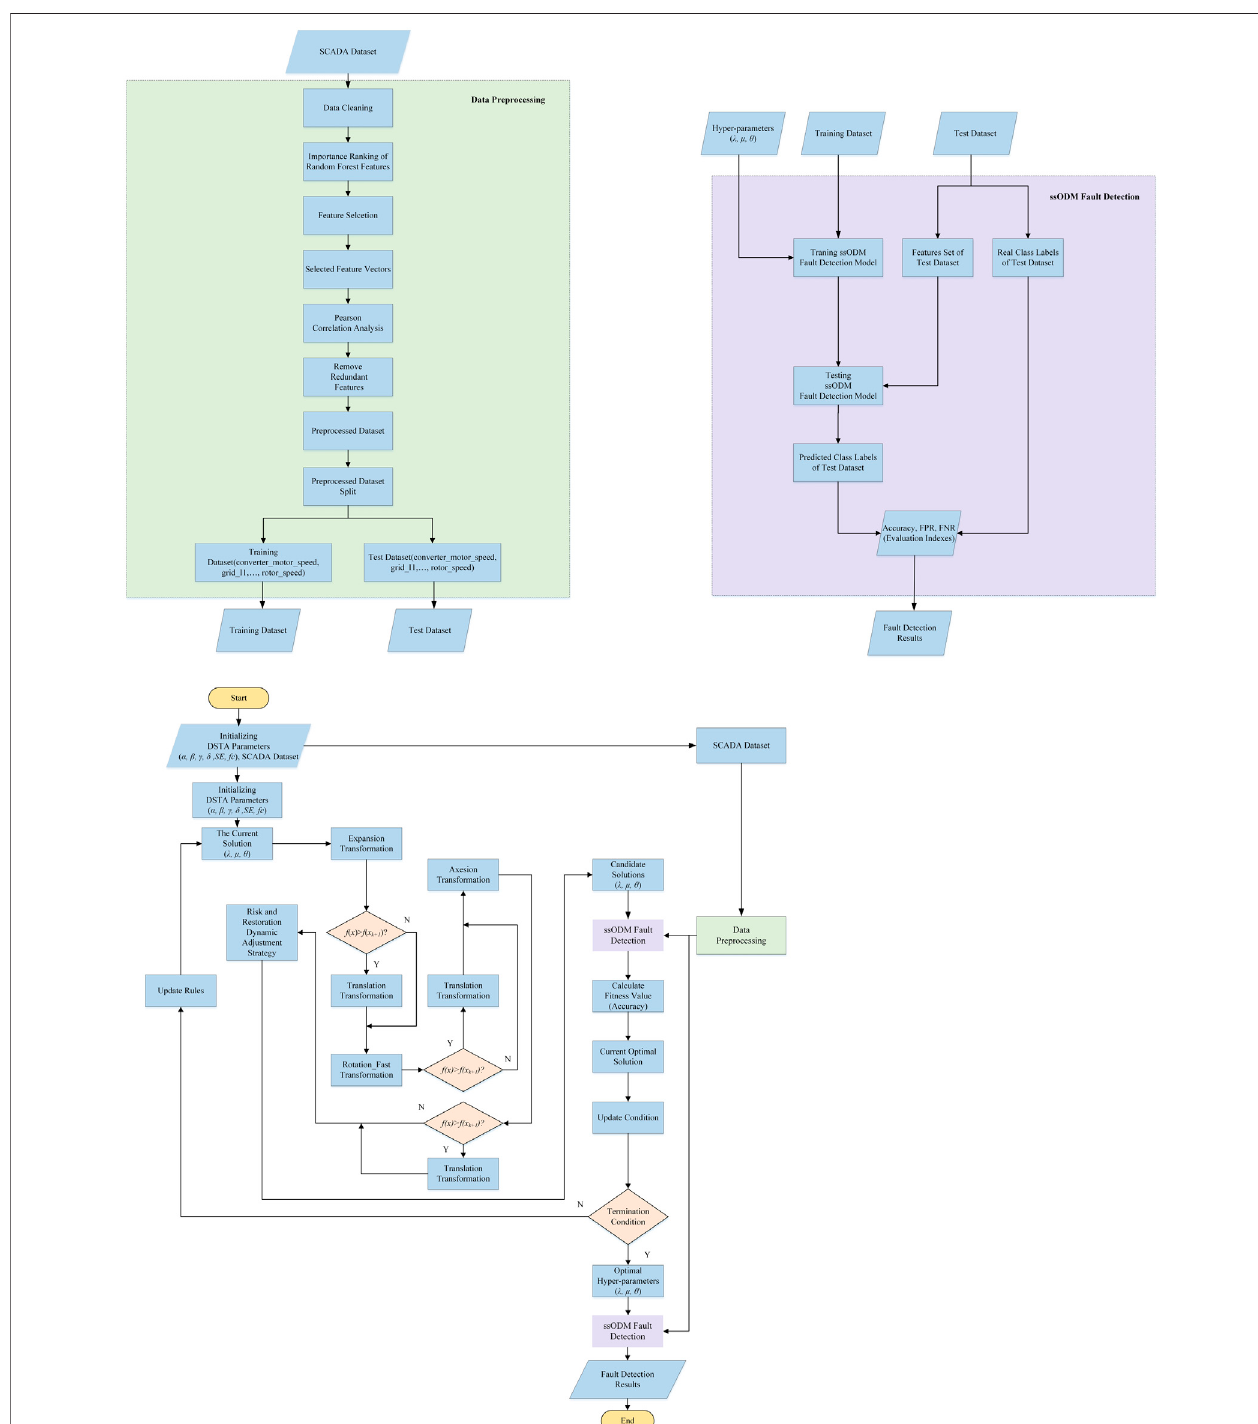
FIGURE 2 | Fault detection flowchart of wind turbine pitch system based on ssODM-DSTA.